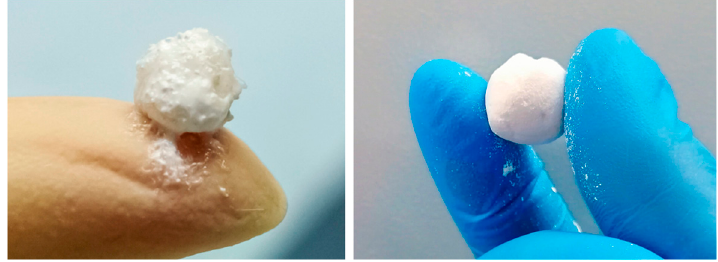
Figure 2. Hydrogels filled with a mixture of HAP and β -TCP ( left ) and porous PLA granules ( right ) rolled into a ball.